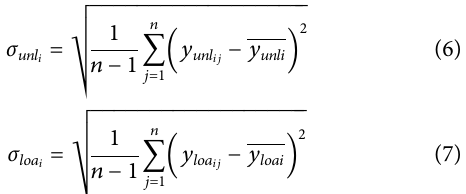
Frontiers in Robotics and AI |